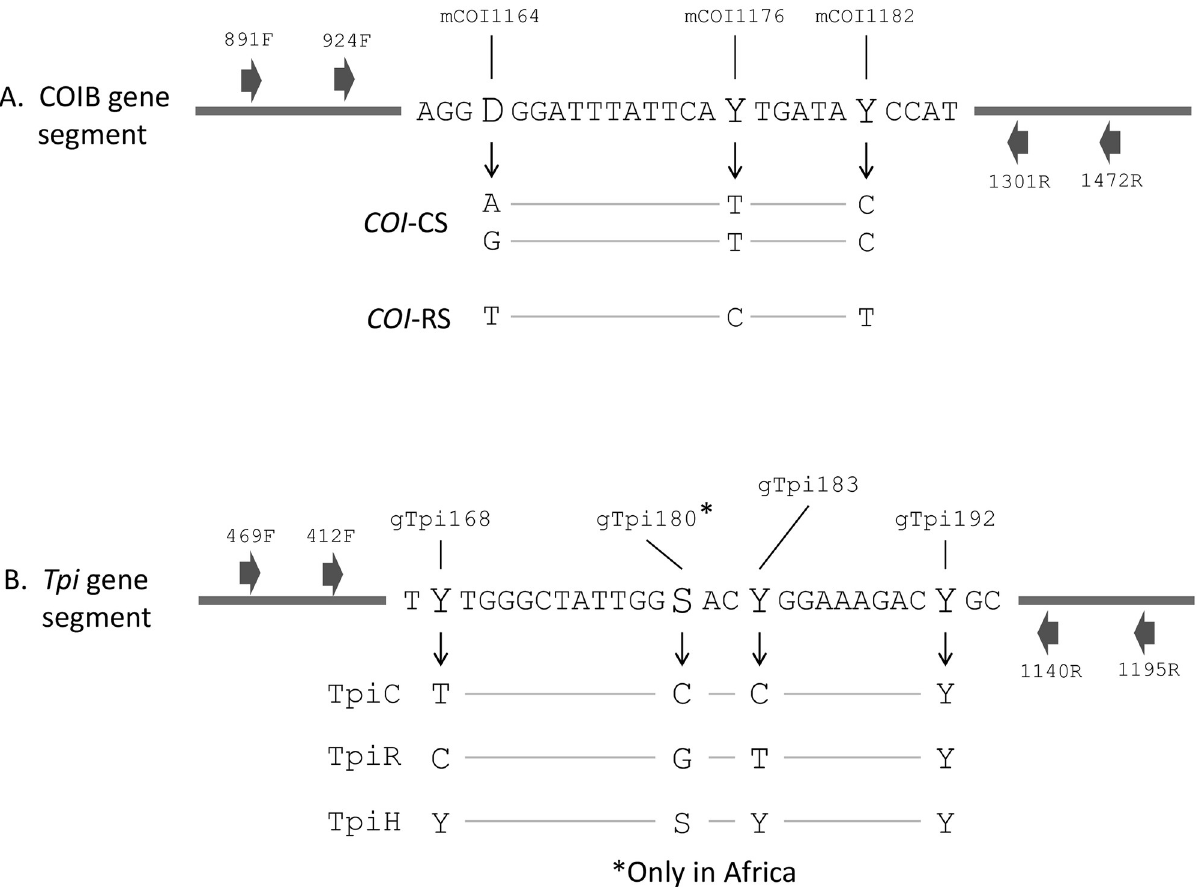
Fig 2. Schematic of gene segments used for the genetic analysis. A. COIB segment of the mitochondrial COI gene showing location of the strain diagnostic mCOI1164 SNP as well as two additional polymorphic sites showing the same strain-specificity. Nucleotides observed at each SNP are listed below arrows and the configurations associated with COI -CS and COI -RS described. B. Segment of the nuclear Tpi gene showing location of the gTpi183 site that is diagnostic of strain identity in Western Hemisphere populations. Site gTpi168 shows a similar polymorphic distribution as gTpi183. The gTpi180 polymorphism is not typically found in the Western Hemisphere but is present in Africa. Nucleotides observed at each site are listed below arrows and the configuration associated with TpiC and TpiR indicated. Because Tpi is Z-linked, males have two copies of the gene and so can be heterozygous for these polymorphisms (TpiH). Site gTpi192 is polymorphic for C or T in both strains (strain nonspecific). Nomenclature follows IUPAC convention where Y = C or T; S = C or G; R = A or G; and D = A, G, or T. Small block arrows denote location of relevant primers used for PCR and DNA